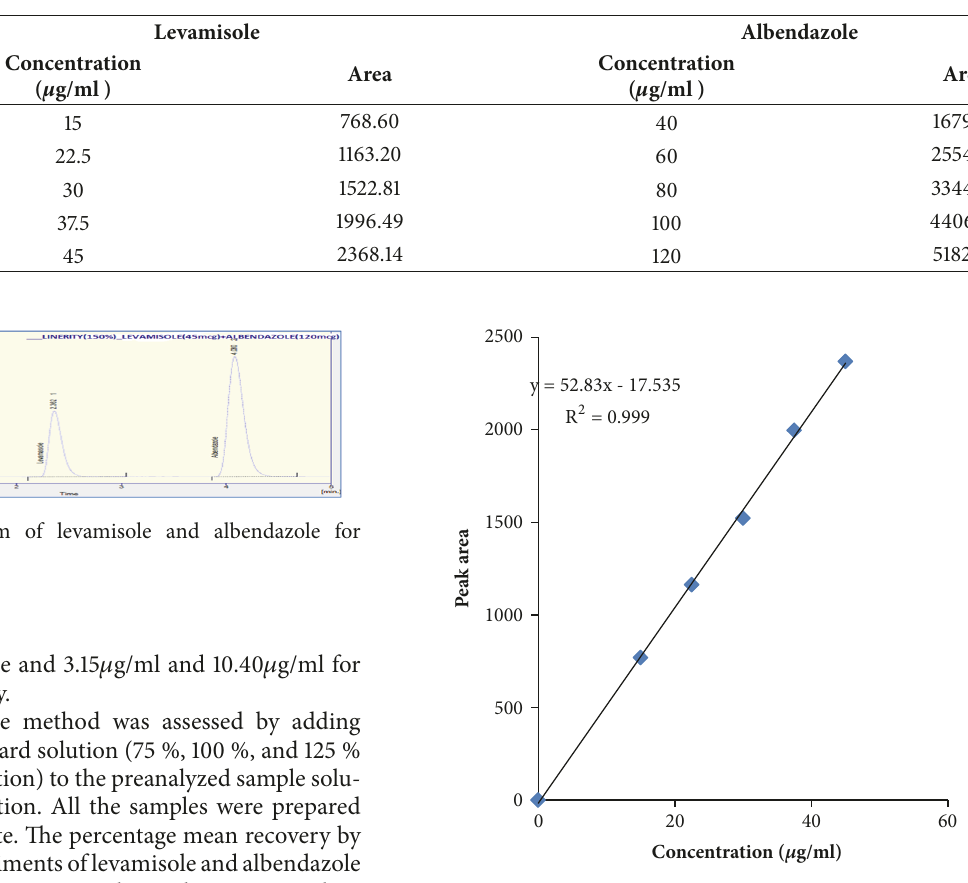
Table 2: Linearity of levamisole and albendazole.